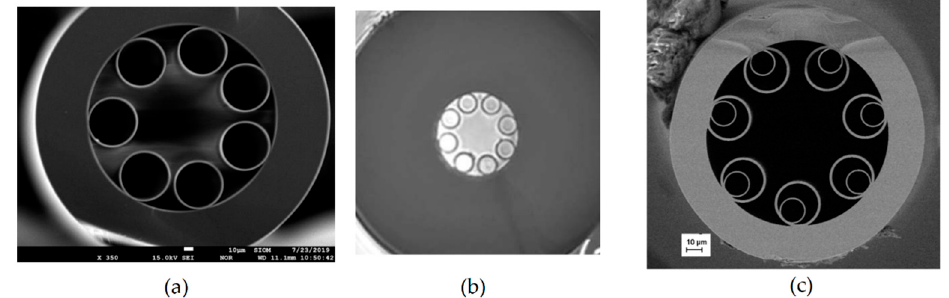
Figure 11. SEM images of examples of NC HCFs: ( a , b ) revolver / tubular HCFs; ( c ) revolver / tubular HCF with double nested capillaries. ( a ) Reprinted from [65]; ( b ) reprinted with permission from [66], © The Optical Society; ( c ) reprinted with permission from [67], © The Optical Society.